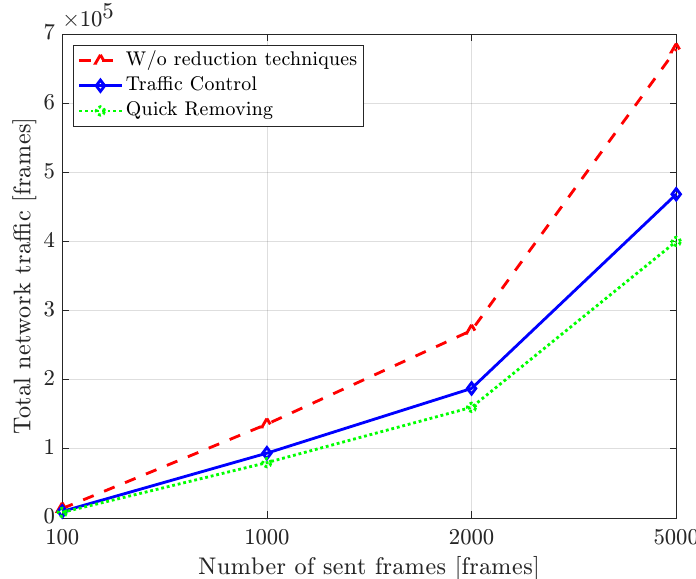
Figure 9. Traffic-reduction performance against numbers of sent frames in the proposed architecture.